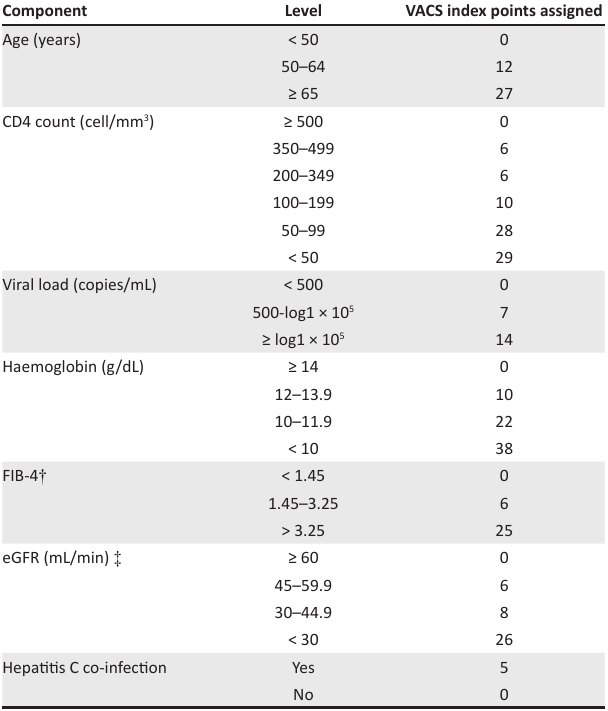
TABLE 1-A5: A Restricted VACS index. The risk of mortality of PLWHIV on at least 12 months of ART increases with a rising VACS score. (Max. vacs score= 164). 30 Component Level VACS index points assigned Age (years) < 50